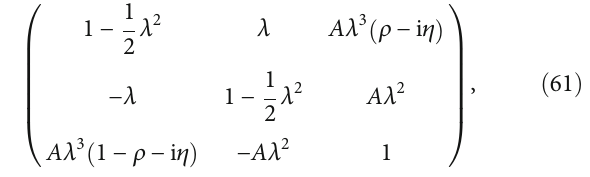
Figure 3. It is found that the CP violation can be enhanced (cid:1) ⟶ ρ 0 ð ω Þ K ∗ 0 via ρ − ω mixing for the decay channel B 0 s ⟶ π + π − K ∗ 0 when the invariant mass of π + π − pair is in the vicinity of the m ω resonance within perturbative QCD scheme. The CP violating asymmetry depends on the weak phase di ff erence ϕ from CKM matrix elements and the strong phase di ff erence δ in the Eq. (34). The CKM matrix ele- ments, which relate to (cid:1) ρ , A , (cid:1) η , and λ , are given in Eq. (63). The uncertainties due to the CKM matrix elements are mostly from ρ and η since λ is well determined. Hence, we take the central value of λ = 0 : 226 in Eq. (65). In the numer- decay process, we use ρ , η , and λ = 0 : 226 which vary among the limiting values. The numerical results are shown from Figure 3 with the di ff erent parameter values of CKM matrix elements. The solid line, dotted line, and dashed line corre- spond to the maximum, middle, and minimum CKM matrix π − K ∗ 0 , respectively. We fi nd that the numerical results of the CP violation are not sensitive to the CKM matrix ele- ments for the di ff erent values of ρ and η . In Figure 3, we ffiffi p show the plot of CP violation as a function of in the per- s turbative QCD. From the fi gure, one can see the CP viola- ffiffi p tion parameter is dependent on and changes rapidly by s the ρ − ω mixing mechanism when the invariant mass of π + π − pair is in the vicinity of the m ω resonance. From the numerical results, it is found that the CP violating asymme- try is large and ranges from - 50 : 19 % to 43 : 02 % via the ρ − ω mixing mechanism for the process. The maximum